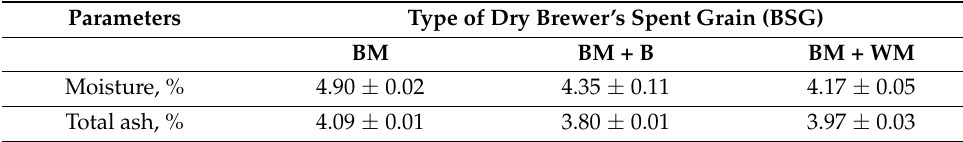
Table 2. Composition of samples of dry spent